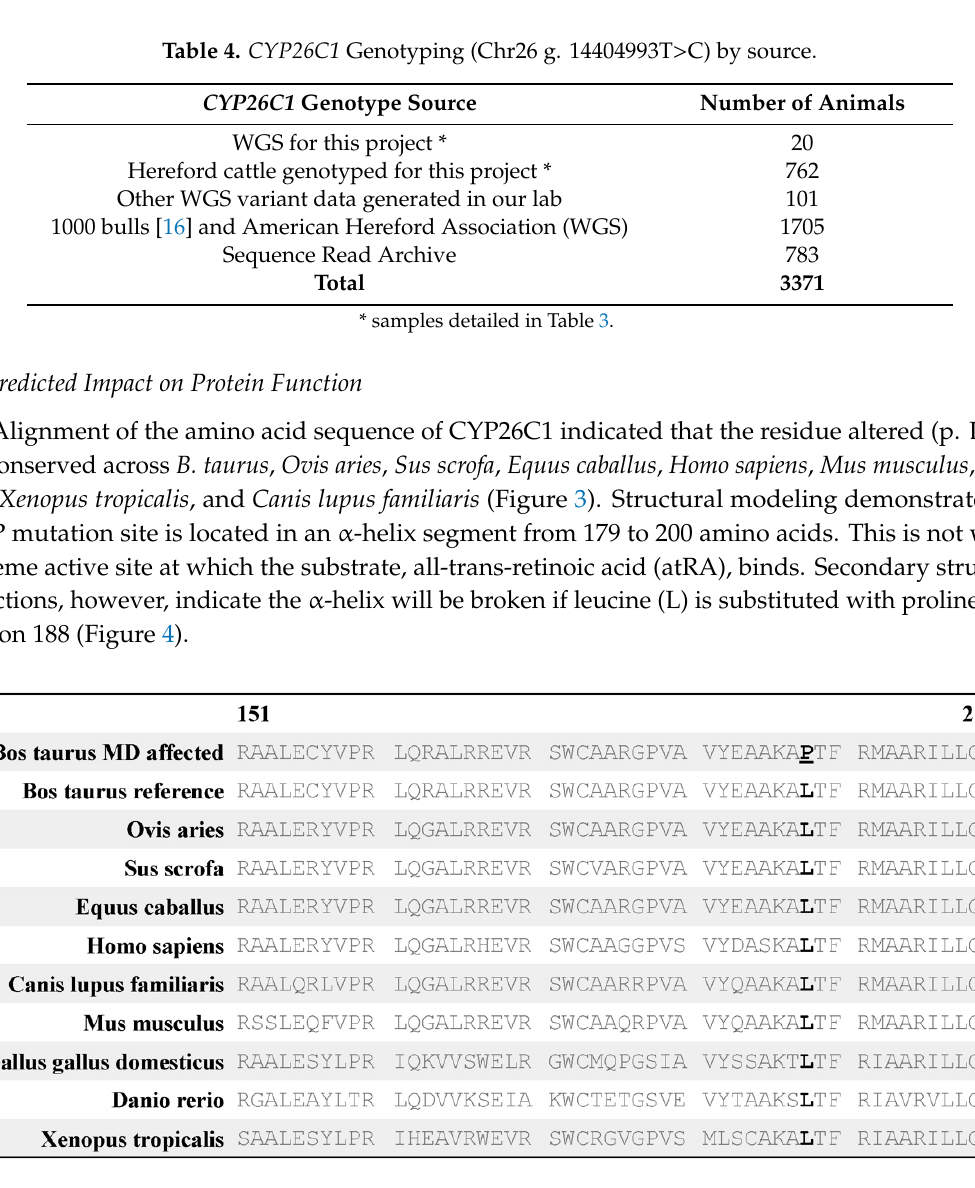
Figure 3. Conservation of the CYP26C1 protein across species. Shown is a portion of the CYP26C1 protein (amino acids 151 to 200 of 523 in the ARS-UCD1.2 reference assembly). Amino acid 188 (bold), altered in mandibulofacial dysostosis calves, is conserved across all other species studied.